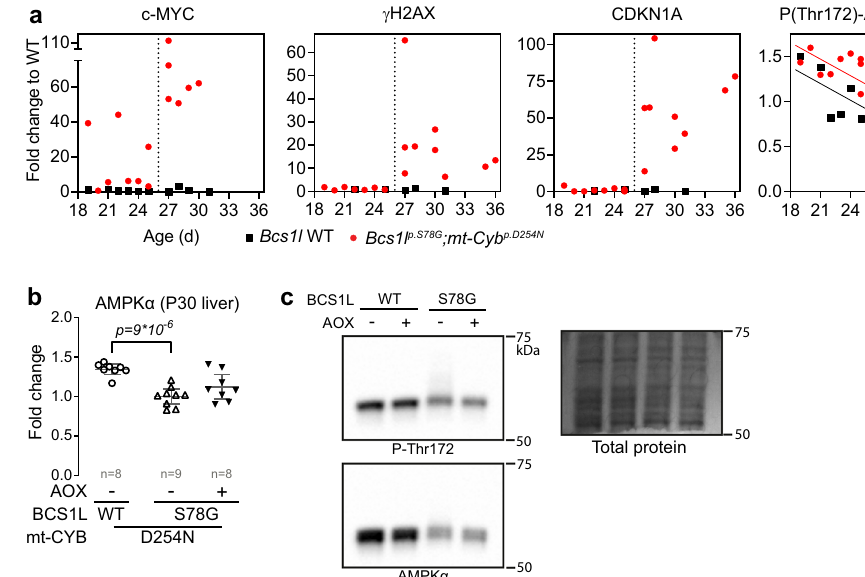
Fig. 8 | c-MYC upregulation precedes the DNA damage and cell cycle arrest. a Hepatic c-MYC, CDKN1A,and γ H2AXexpression, and the phosphorylation status of AMPK α and eIF2 α plotted against mouse age (Western blot quanti fi cations). b , c Total amount AMPK α in P30 liver lysates and a representative Western blot.